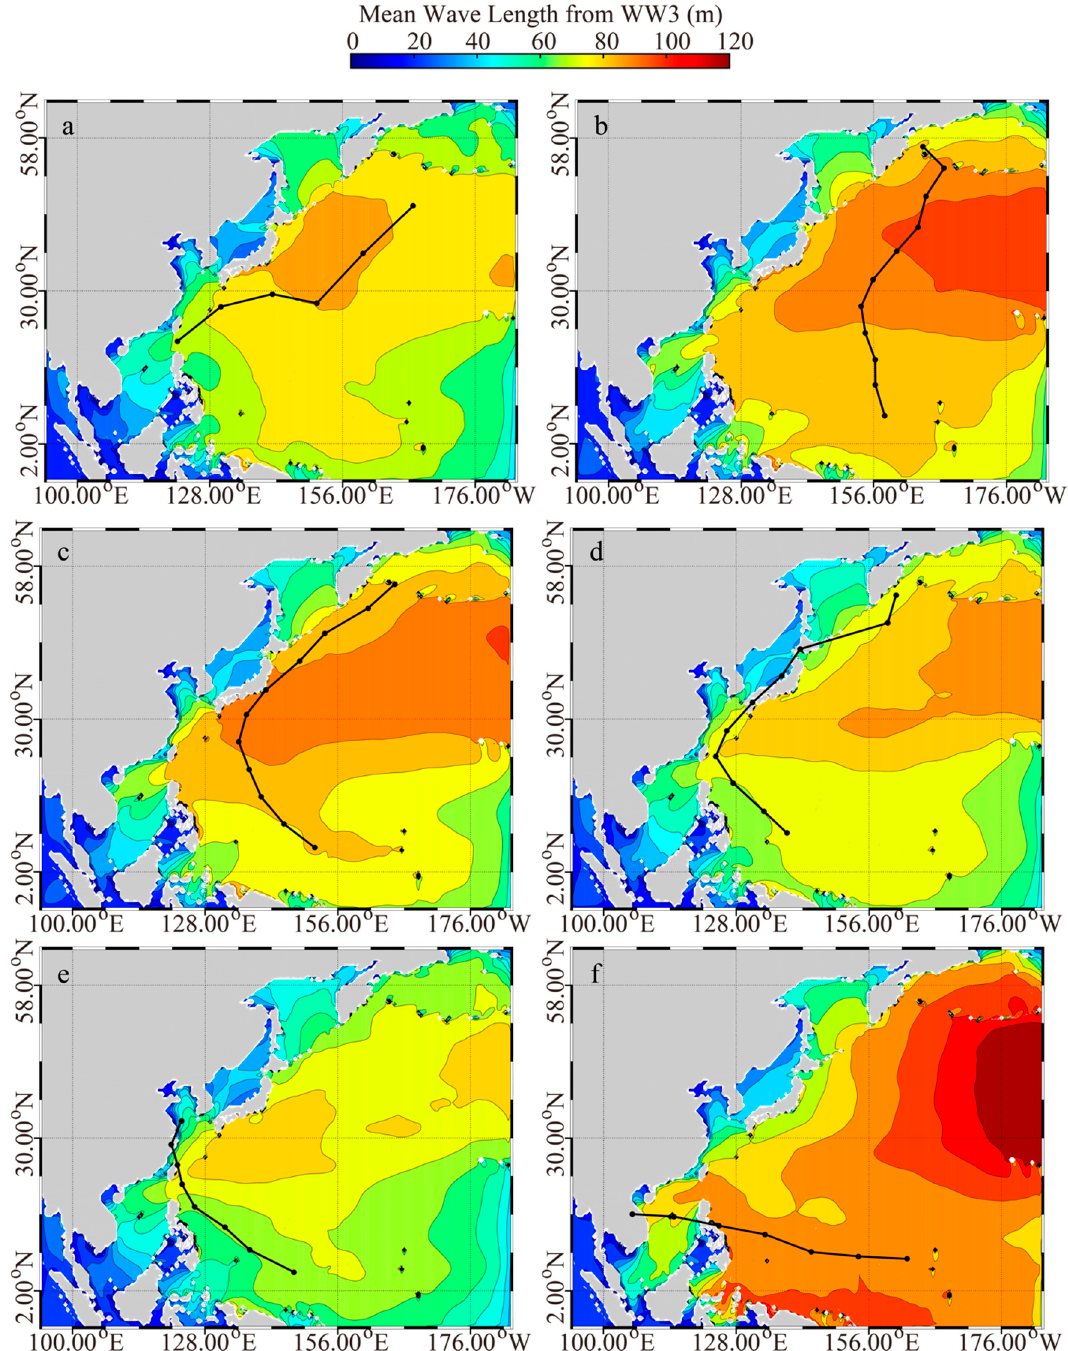
Figure 6. The average result of MWL from the WW3 for each type of typhoon paths from 1998 to 2018, in which the black polylines represent the typical paths for each type of typhoon paths. ( a ) Northeast shift; ( b ) east turn; ( c ) middle turn; ( d ) west turn; ( e ) northwest shift; and ( f ) west